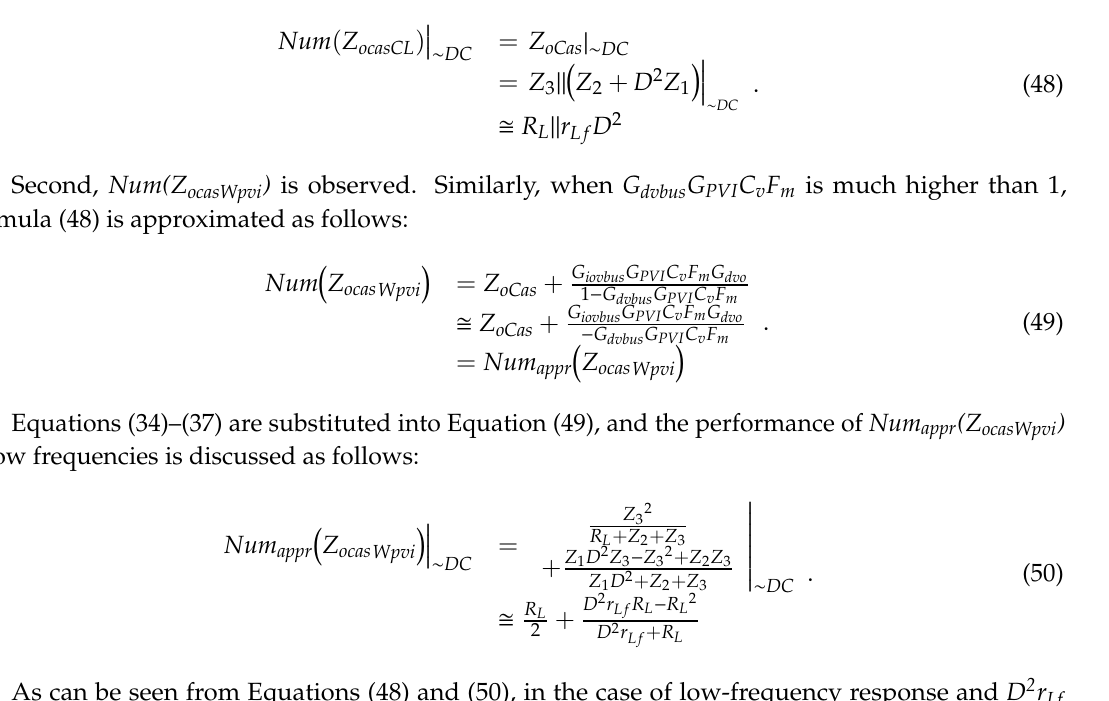
Figure 21. Bode plots of | Z ocasWpvi | under different Z PVI designs.